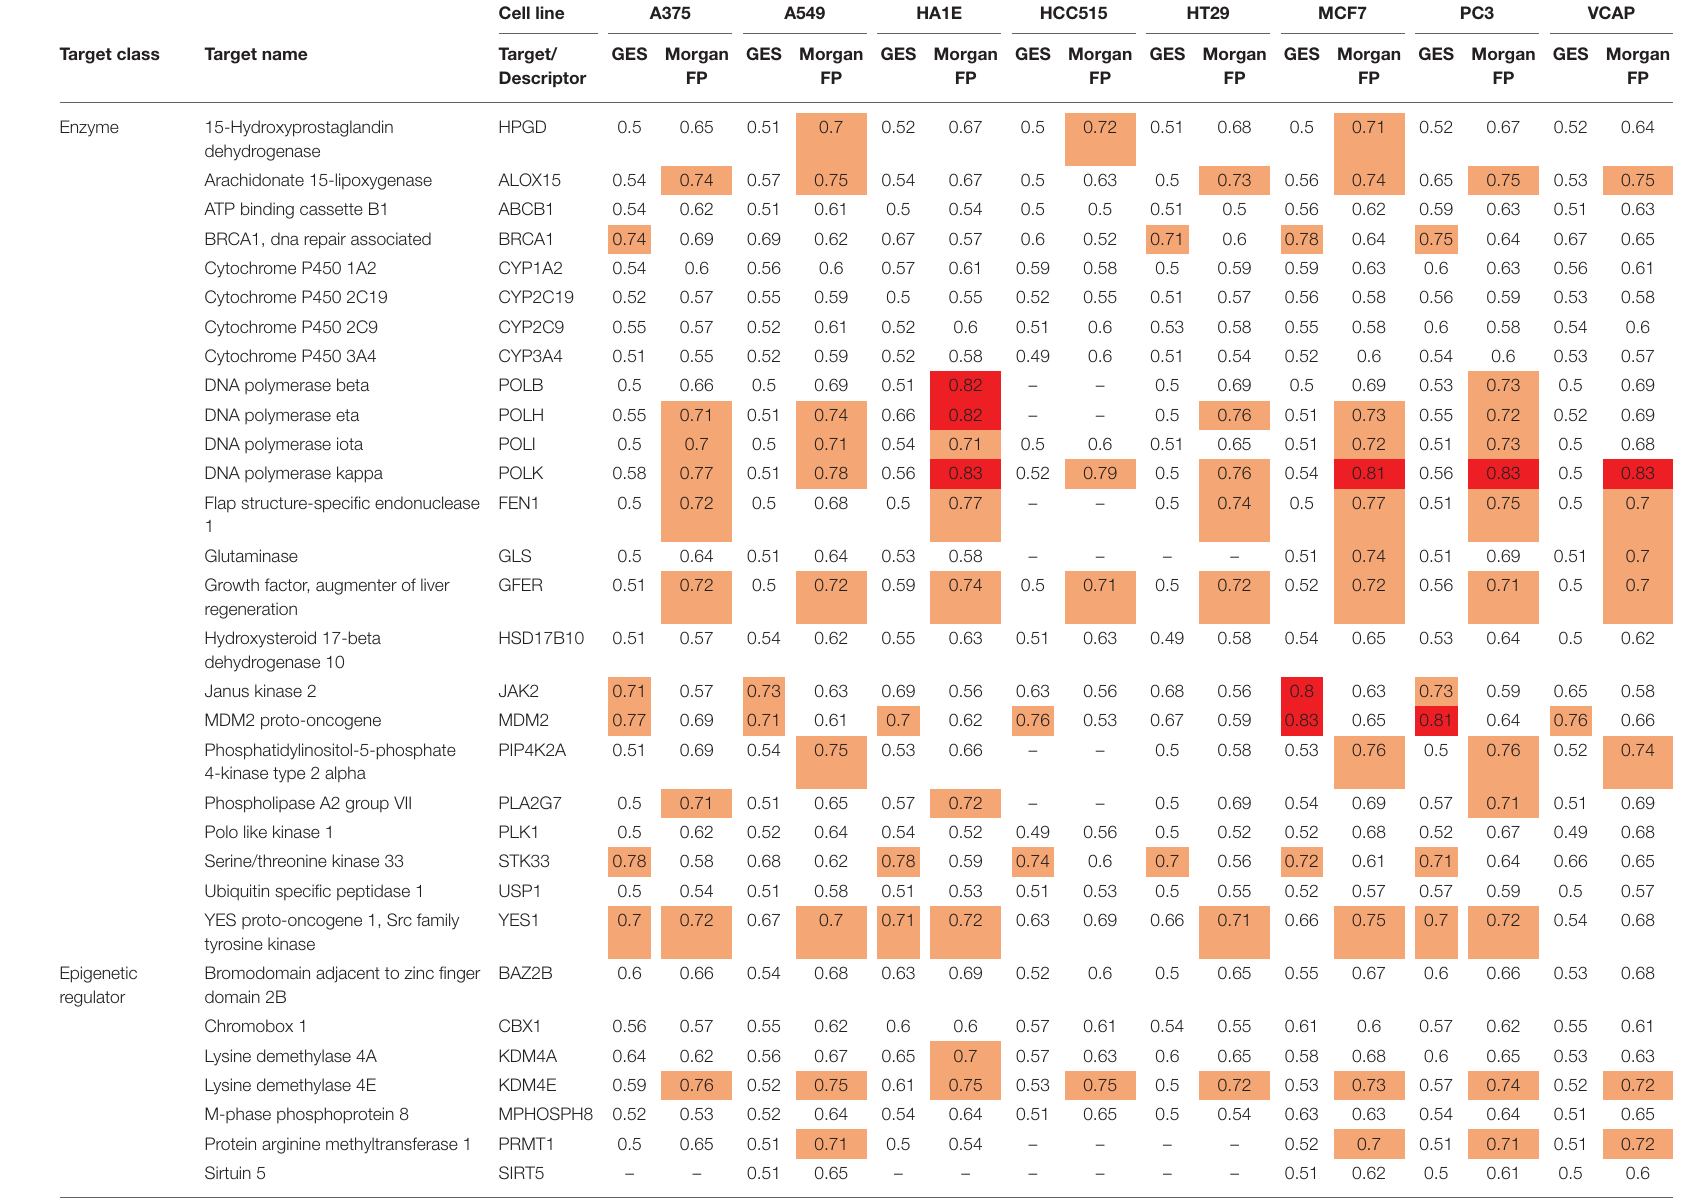
TABLE 3 | Mean BAs of models (mean per